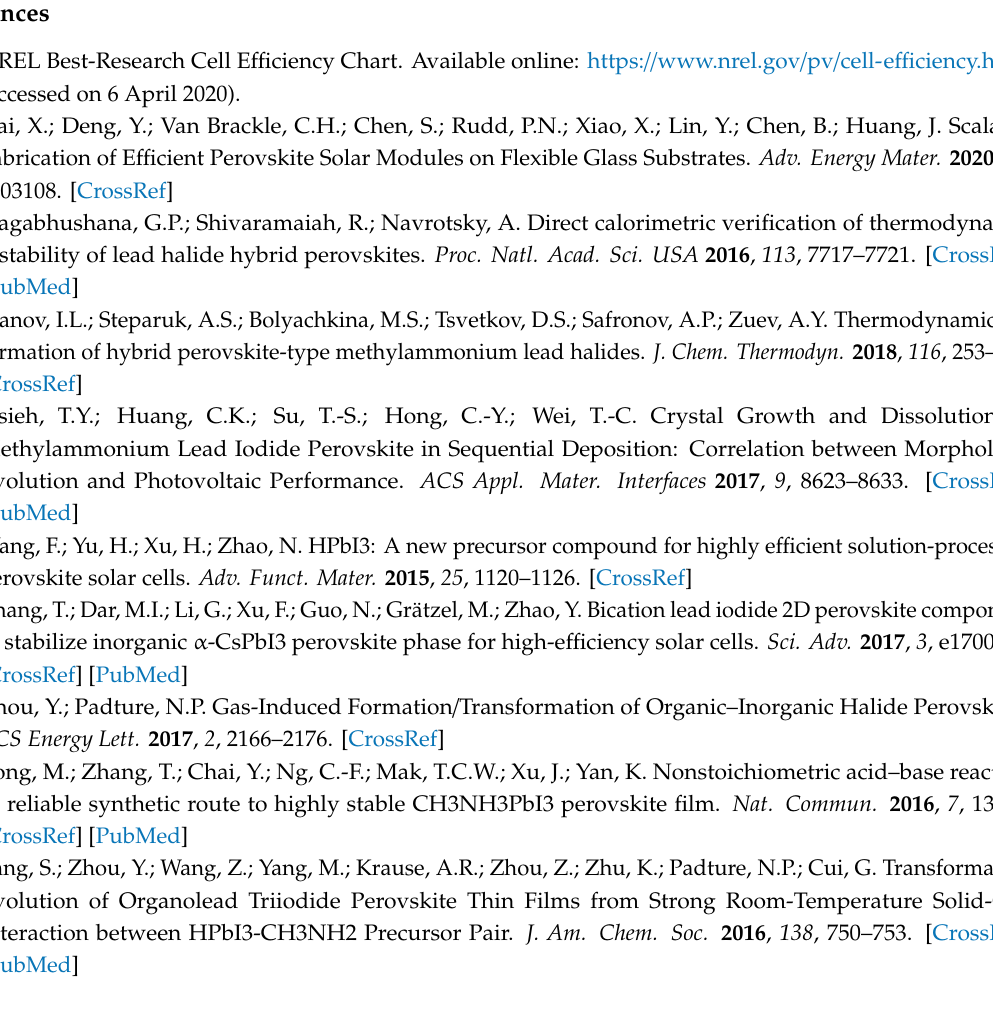
information: Figure S1: Optical microscopy photos of the crystals of the adduct: freshly grown (a), aged in 1 min (b), aged in 2 min (c); Figure S2: Di ff raction pattern of the Phase-1 powder. The captions indicate the positions of reflections, symbols “x” and “y” indicate the a ffi liation for one of the two distinct groups of reflections; Table S1: The best fitted refined lattice parameters of the Phase-1 within assumption of orthorhombic unit cell; Figure S3: Di ff raction pattern of the Phase-1 in Pbcm space group (parameters listed in Table S2): experimental (black) and simulated (red); Table S2: The best fitted refined lattice parameters of the Phase-1 within assumption of monoclinic unit cell; Figure S4: Di ff raction pattern of the Phase-1: with P 2 1 / c space group (parameters listed in Table S2): experimental (black) and simulated (red); Figure S5: Probable crystal structure of Phase-1 (space group Pbcm ) with a single chains of PbI 6 octahedra in yz (a) and xy (b)